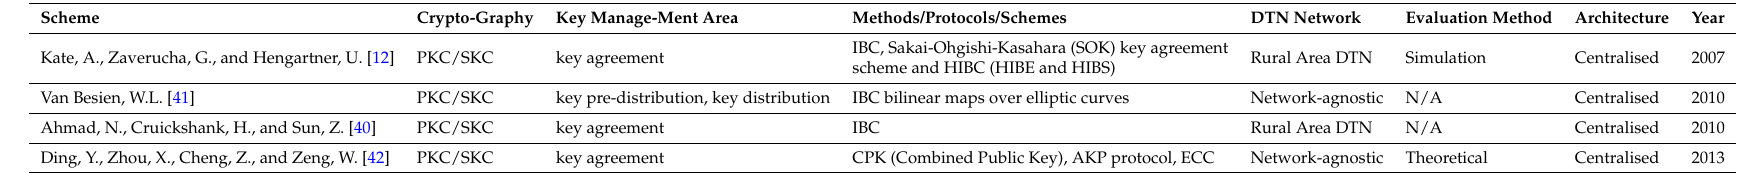
Table 2. Comparison of two-party IBC-based key establishment